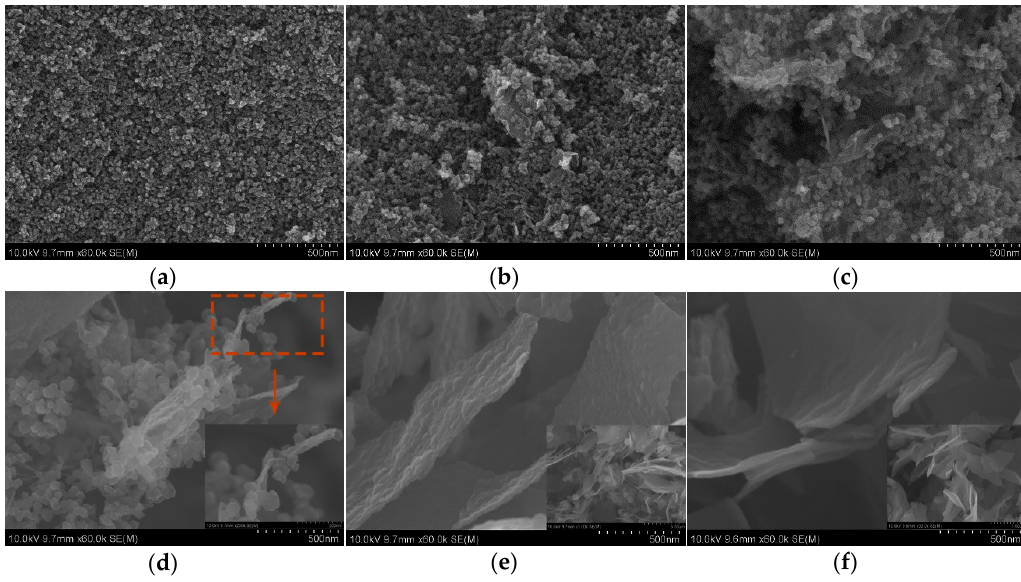
Figure 3. Scanning electron microscope (SEM) images of ( a ) CRF; ( b ) GCCA-300; ( c ) GCCA-200; ( d ) GCCA-150; ( e ) GCCA-100; and ( f ) GCCA-50.